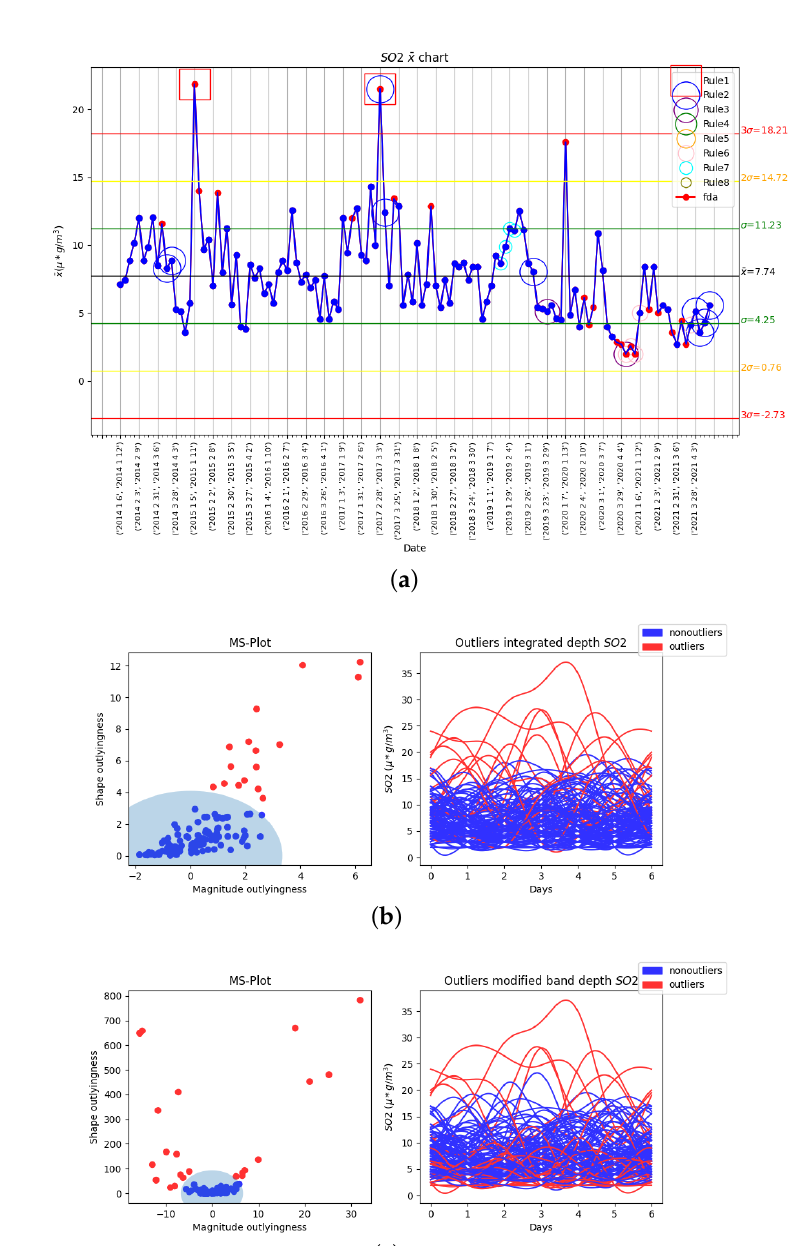
Figure 6. Results of the third phase of the SO 2 analysis: ( a ) ¯ x chart with the weekly rational subgroups of the first four months of every year, the Nelson rules implemented, and the functional outliers detected with the modified band depth marked with red dots; ( b ) (left) Cartesian representation of the magnitude and shape outlyingness of each function with the integrated depth; (right) functional plot of the SO 2 values of each week; ( c ) (left) Cartesian representation of the magnitude and shape outlyingness of each function with the modified band depth; (right) functional plot of the SO 2 values of each